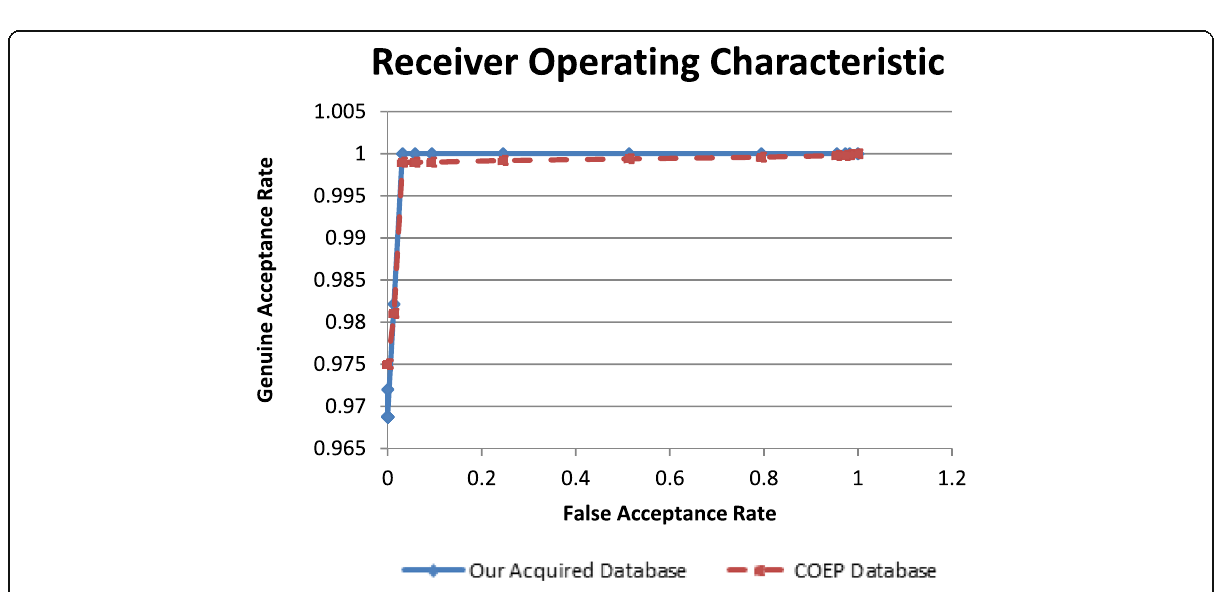
Fig. 8 ROC of palm print modality for both the databases using approximate coefficients